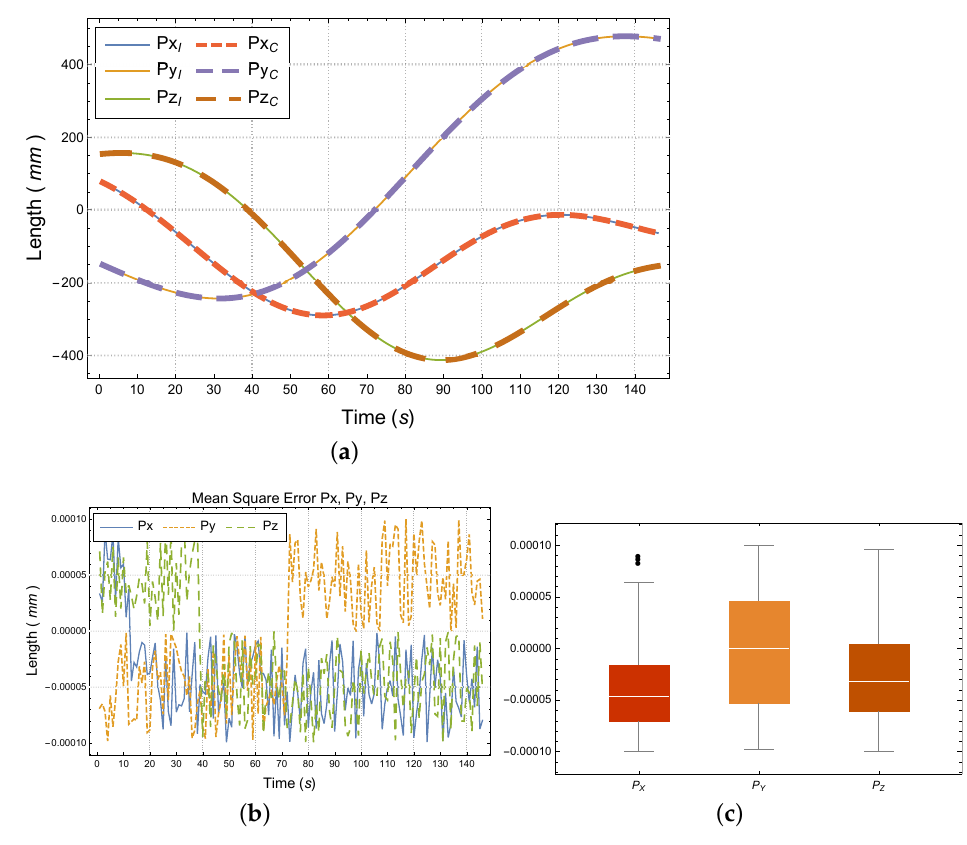
Figure 8. A comparison of the mathematical models of the forward kinematics. ( a ) Comparison of the position ( P X , P Y , P Z ) between CAD mechanical design and forward kinematics equations. ( b ) Mean Square Error of the forward kinematics. ( c ) Box plot of the forward kinematics.